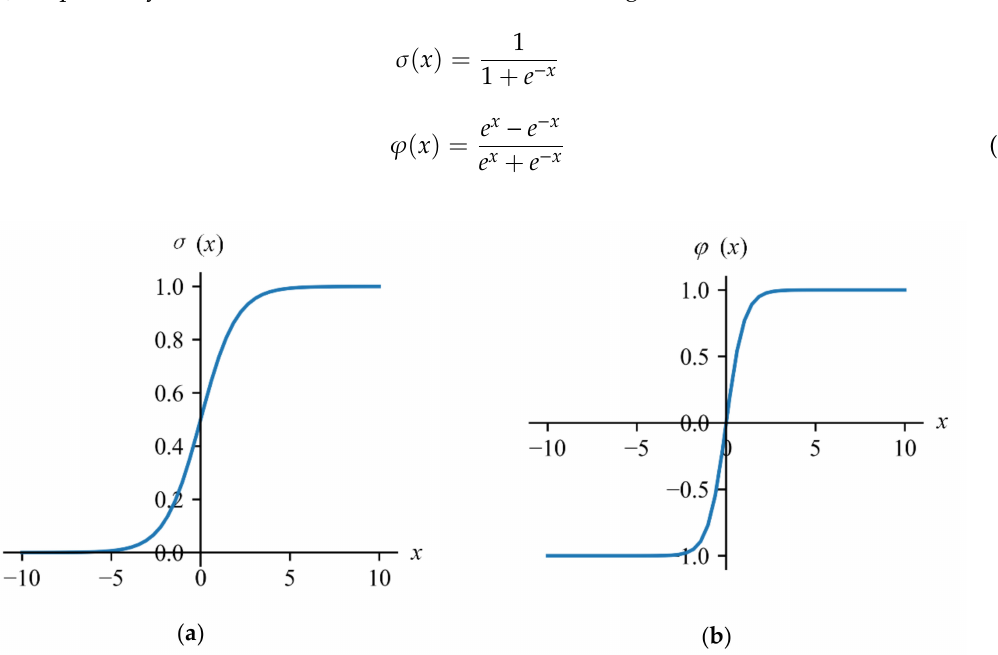
Figure 7. ( a ) The functional curve of the activation function σ ; and ( b ) the functional curve of activation function ϕ